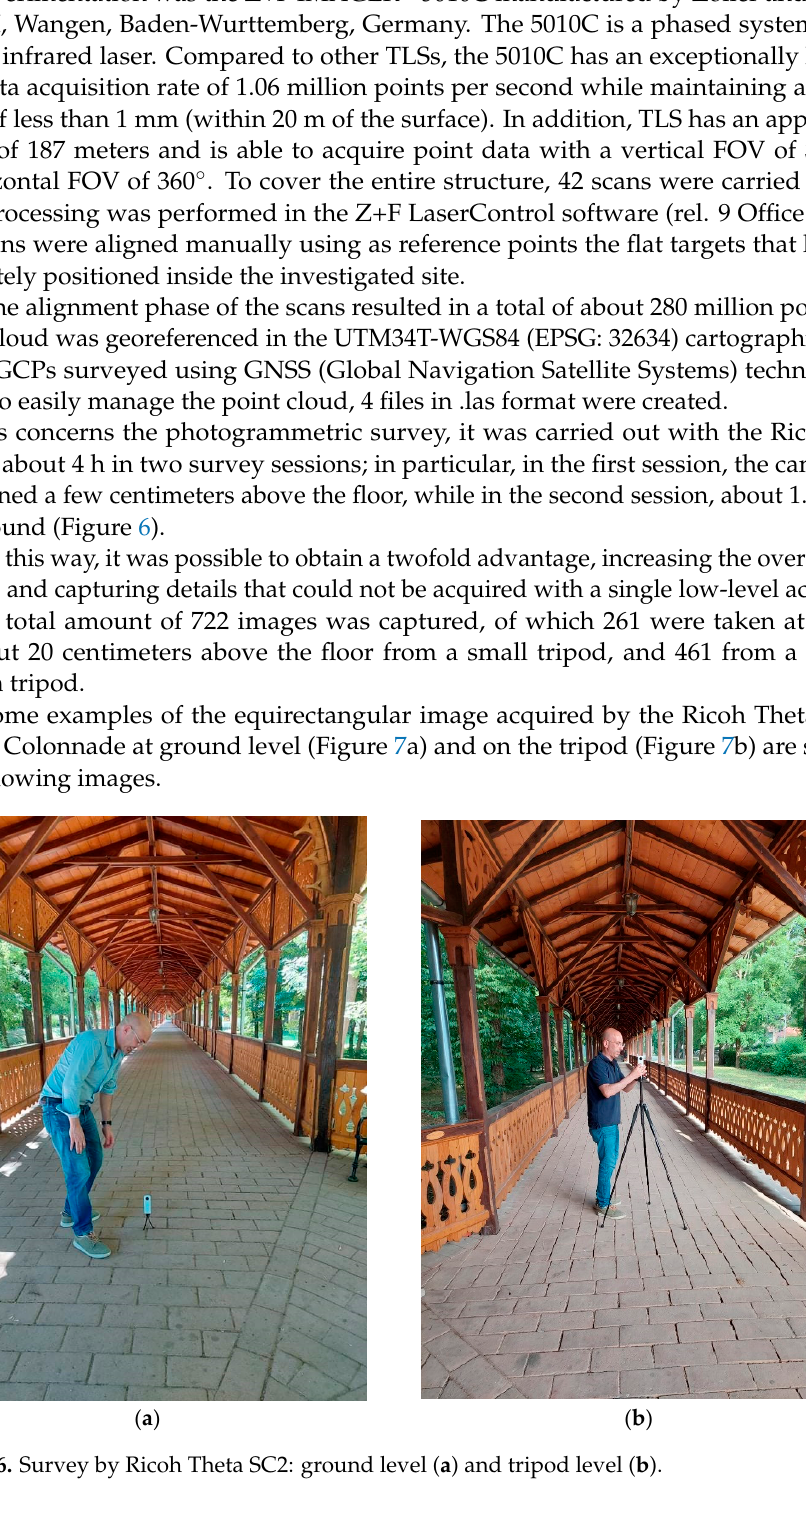
( b ) Figure 7. Examples of equirectangular images acquired by the Ricoh Theta SC2 camera from the ground ( a ) and from the tripod ( b ). The post-processing of the images was carried out, taking into account the result ob- tained in the laboratory test, in Agisoft Metashape software. Earlier to the image align- ment step, a pre-processing of the images was carried out. In fact, in order to avoid effects on the images (chromatic aberrations, blooming) that could alter both the metric and ra- diometric quality of the images, appropriate masks were made. Furthermore, in order to improve the quality of the images, a pre-processing relative to the brightness, contrast, and exposure of the single images was carried out. Despite the high overlap of the images, the software was not able to align all the images at the same time. For this reason, it was decided to divide the acquired images spatially into various datasets. In particular, the complexity of the site and the quality of the sensor used for the experimentation made it necessary to process the data by discretizing the homogeneous geometric elements in or- der to obtain detailed photogrammetric models without having to incur problems related to the change of convergence of the morphology of the structure taken into consideration. The only way to elaborate a complete photogrammetric dataset of the site was to divide the images into 10 datasets. In this way, it was possible to obtain a 3D reconstruction of the site. From a statistical point of view, it was noted that only the division into 10 datasets (Figure 8) was able to give the best result. In other words, the dataset was first processed in a single process; subsequently, further, sub-datasets were created and processed indi- vidually until the best result was obtained through photogrammetric processing.